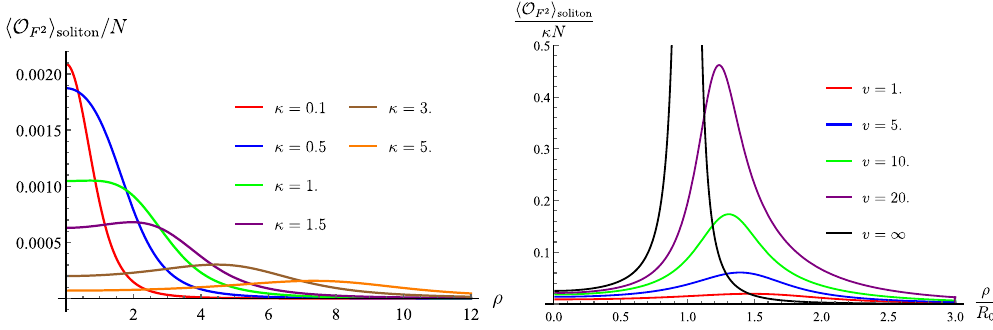
Figure 10 . Left: our numerical results for hO i soliton /N from eq. (5.5) as a function of ρ/R 0 F 2 with R 0 = κ/v for v = 1 and κ = 0 . 1 (red), 0 . 5 (blue), 1 (green), 1 . 5 (purple), 3 (brown), and 5 (orange). Right: our numerical results for hO i soliton / ( Nκ ) from eq. (5.5) as a function of ρ/R 0 F 2 with κ = v and v = 1 (red), 5 (blue), 10 (green), and 20 (brown). The black curve corresponds to the analytical solution in the v → ∞ limit given by eq.